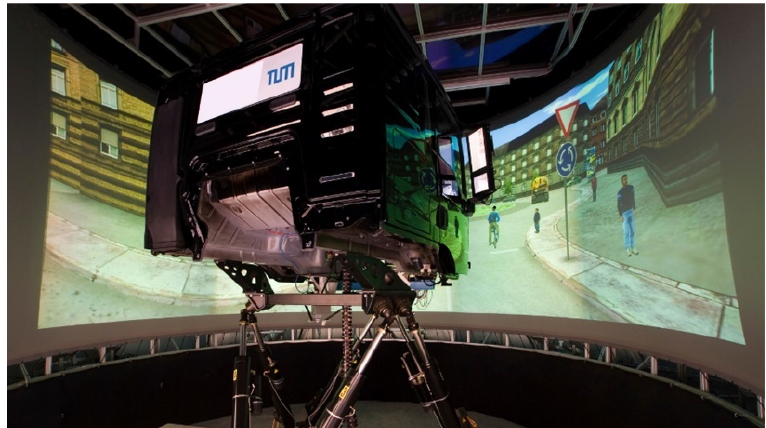
Figure 3. Dynamic truck driving